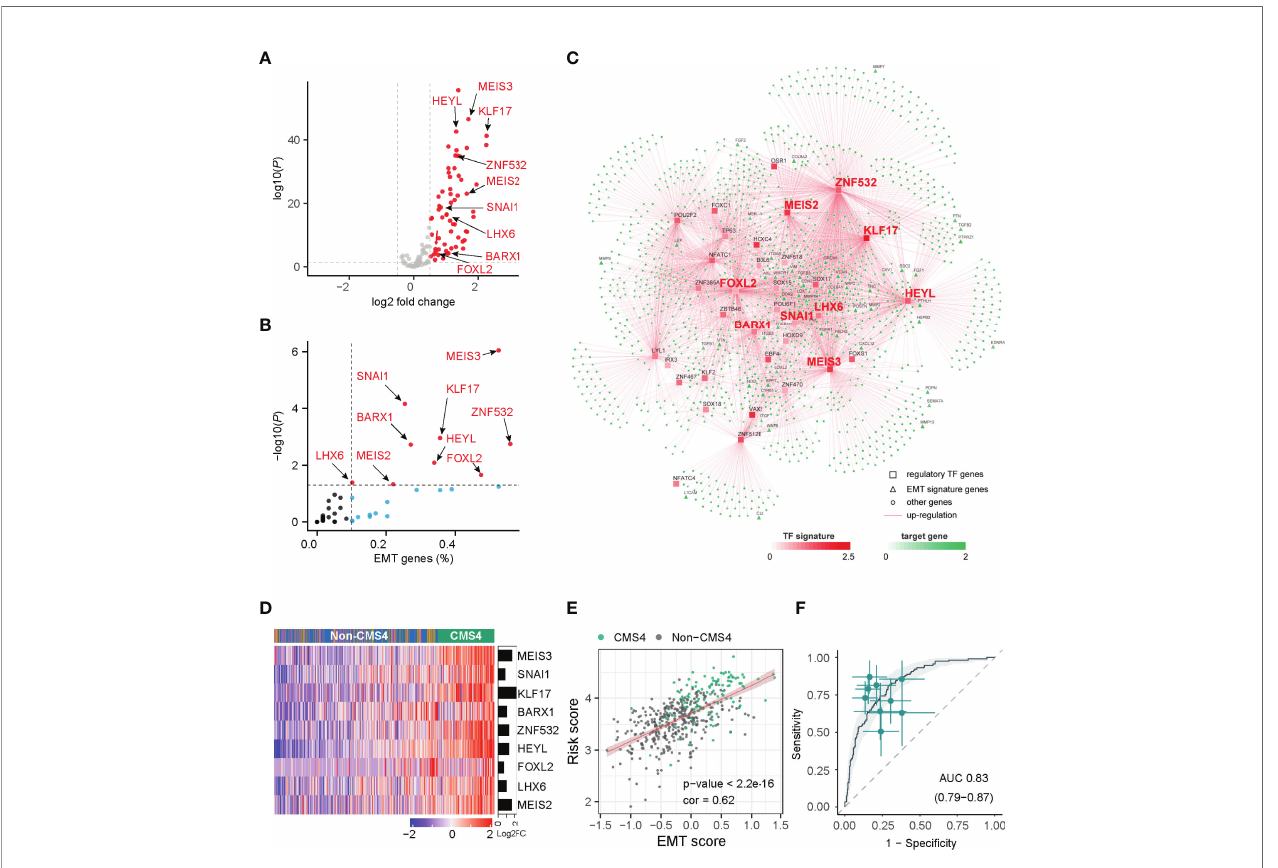
FIGURE 1 | Network inference identi fi ed nine transcription factors gene as key regulators of CMS4 subtype in colorectal cancer. (A) Volcano plot of the differentially expressed genes in the CMS4 vs. other CMS subtype and highlighting the nine candidate transcription factors genes. (B) All these nine transcription factor genes can regulate EMT genes. (C) Integrated network showing the relationships between the expression pro fi le of nine transcription factor genes and target genes. (D) Heatmap of the expression of nine candidate transcription factors-related genes in CMS4 and other CMSs. (E) Correlation analysis demonstrated a positive correlation between the TF-9 signature risk score and EMT score (correlation coef fi cient = 0.62, P < 0.001). (F) TF-9 can distinguish CMS4 from other CMS subtypes of colorectal cancer, with AUC values of